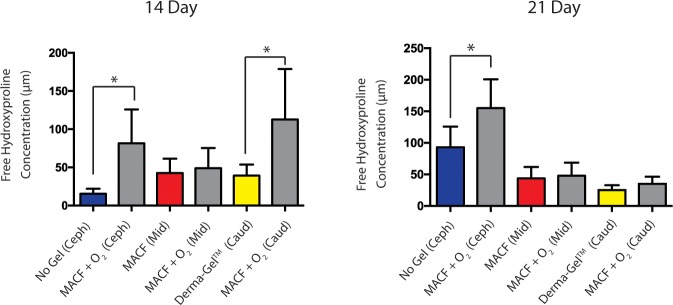
Free hydroxyproline concentration changes in wound samples measured by LC-MS/MS analysis.Regions are denoted as Cephalad (Ceph), middle (Mid), and Caudal (Caud). * denotes significance by one factor ANOVA with Tukey’s post hoc, (p < 0.05). Mean+/-SD, n = 3 (pigs), s = 2 (wounds/region).